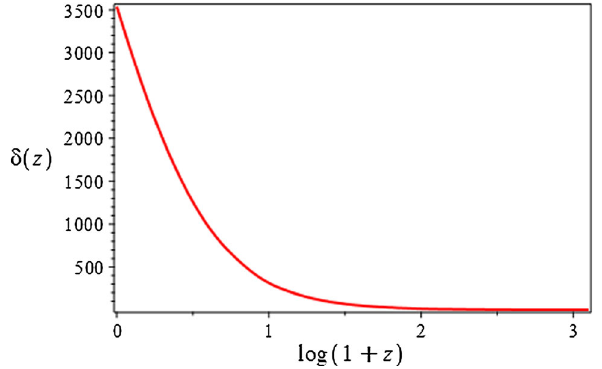
Fig. 3 δ( z ) versus z for Eq. (91) for long-wavelength mode in radiation-dominated Universe for Λ CDM approach and for 1 = Ω r + Ω